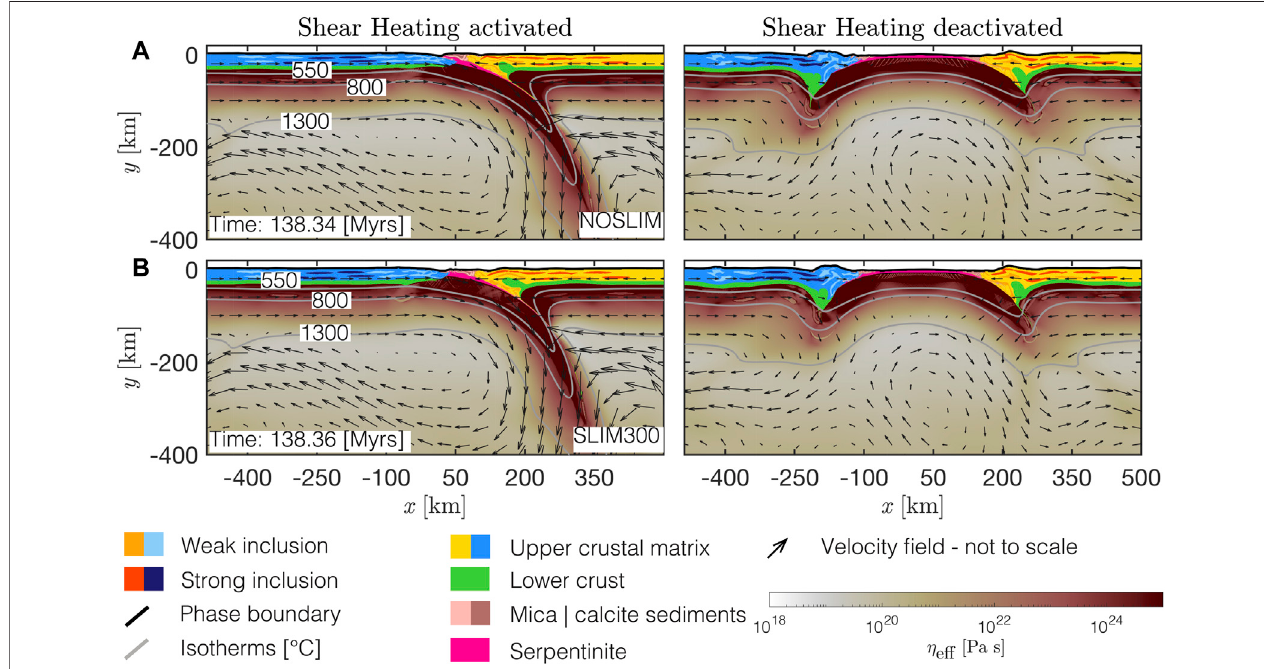
FIGURE 7 | Comparison of NOSLIM (A) and SLIM300 (B) with activated (left column) and deactivated shear heating (right column). While SZI at the right passive margin evolves into a mature subduction zone when shear heatingis activated, buckling and thickening dominates the lithospheric deformation at both passive margins when shear heating is deactivated. Subduction is not initiated in models without shear heating. Colours as indicated in the legend.